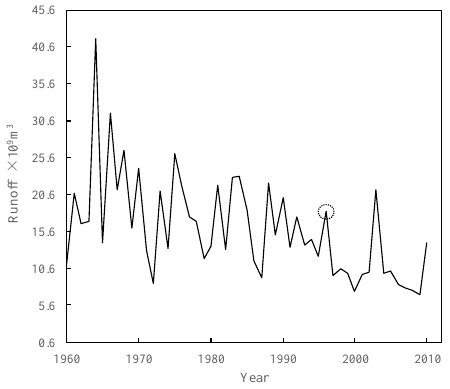
Figure 5. The runoff of Zhangjiashan Station.